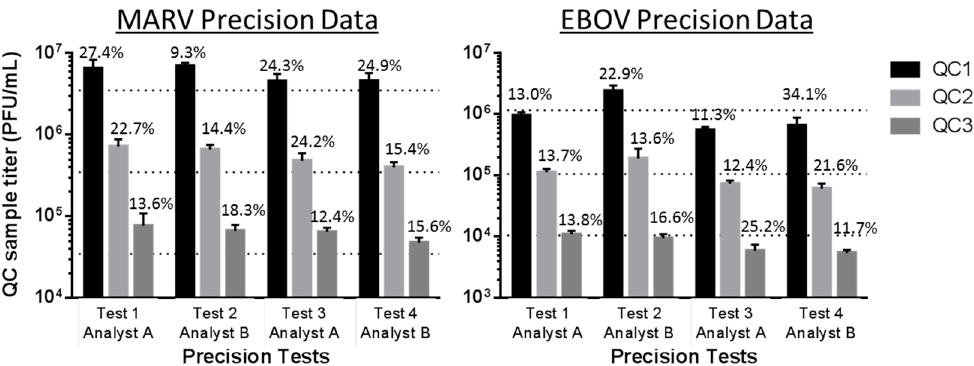
Figure 1. The MARV and EBOV validated plaque assays demonstrate repeatability and intermediate precision. The shaded bars represent average measured titers for QC1, QC2 or QC3 for MARV or EBOV, measured by Analyst A or B in their test performance iteration. Tests 1 and 2 were performed on the same day, but independently by each analyst. Tests 3 and 4 were similarly performed, but on a different day. The three horizontal dotted lines plot the nominal titers of MARV and EBOV QC1, QC2 and QC3. Those nominal titers are presented in Tables 1 and 2. The %CVs for the average observed QC titers are shown above the relevant bars, and the values were assigned a cutoff for acceptance of ≤ 30% for this cell ‐ based biological assay based on historical performance and the analysis of system suitability [13,14].